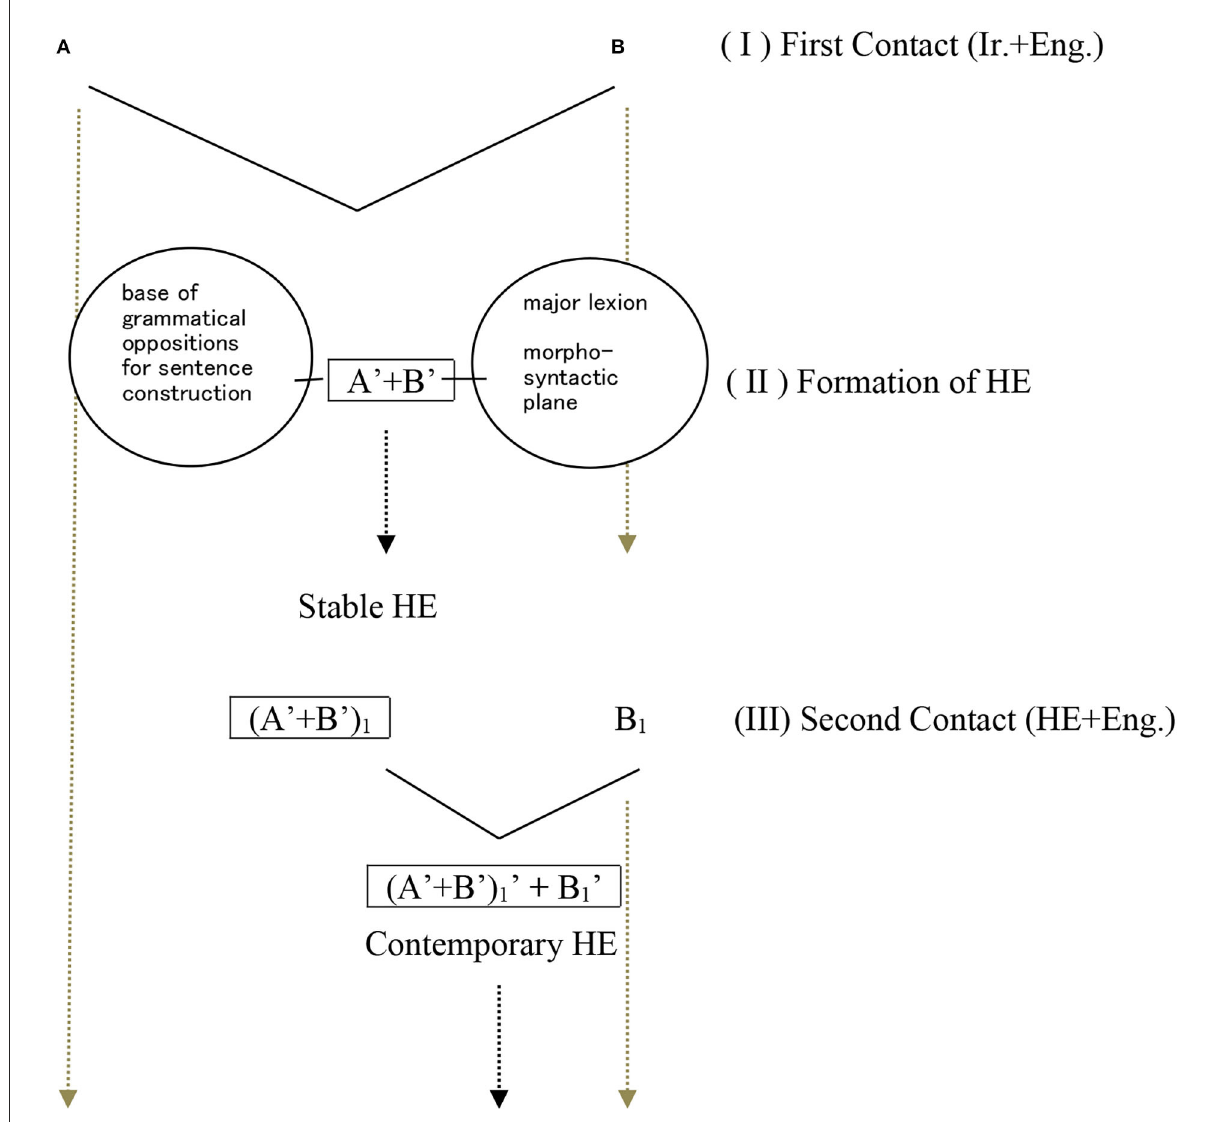
FIGURE2 Grammar formation of